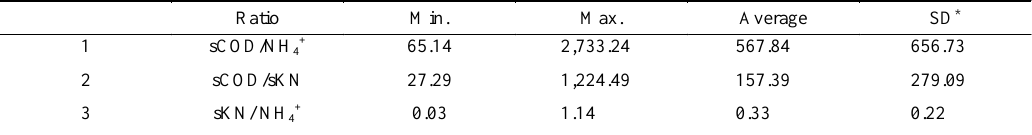
Table 3: Performance